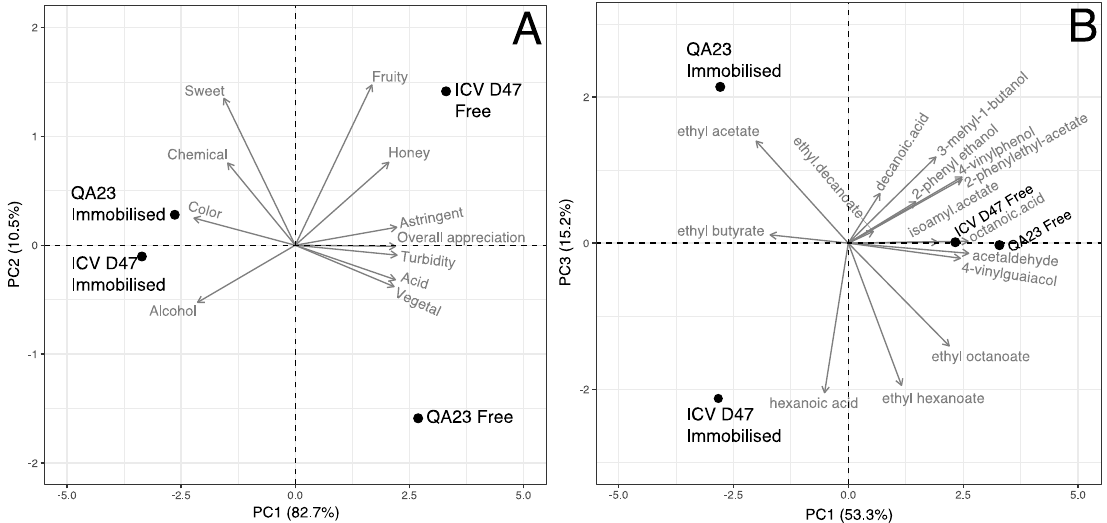
Figure 3. Principal component analysis (PCA) plot of mead obtained by the two strains, QA23 and ICV D47, with free or immobilized cells. PCA biplots of volatile compounds data present in meads obtained by the strains QA23 and ICV D47, with free or immobilized cells: ( A ) PC1 vs PC2; ( B ) PC1 vs